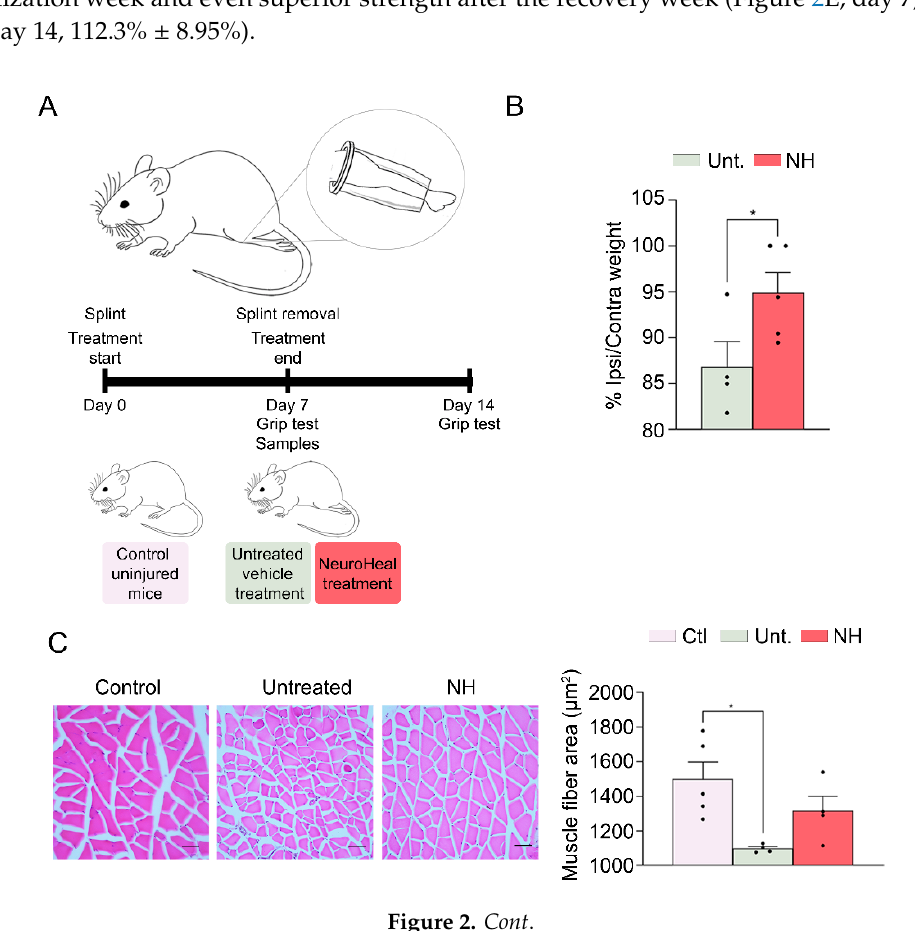
Figure 2. NeuroHeal treatment reduces muscle atrophy by disuse. ( A ) Schematic workflow and experimental groups and ( B ) a bar graph of the gastrocnemius (GA) muscle weight ratio between ipsilateral and contralateral sites at day 7 ( n = 3–4; t-test, * p < 0.05). ( C ) Left, representative